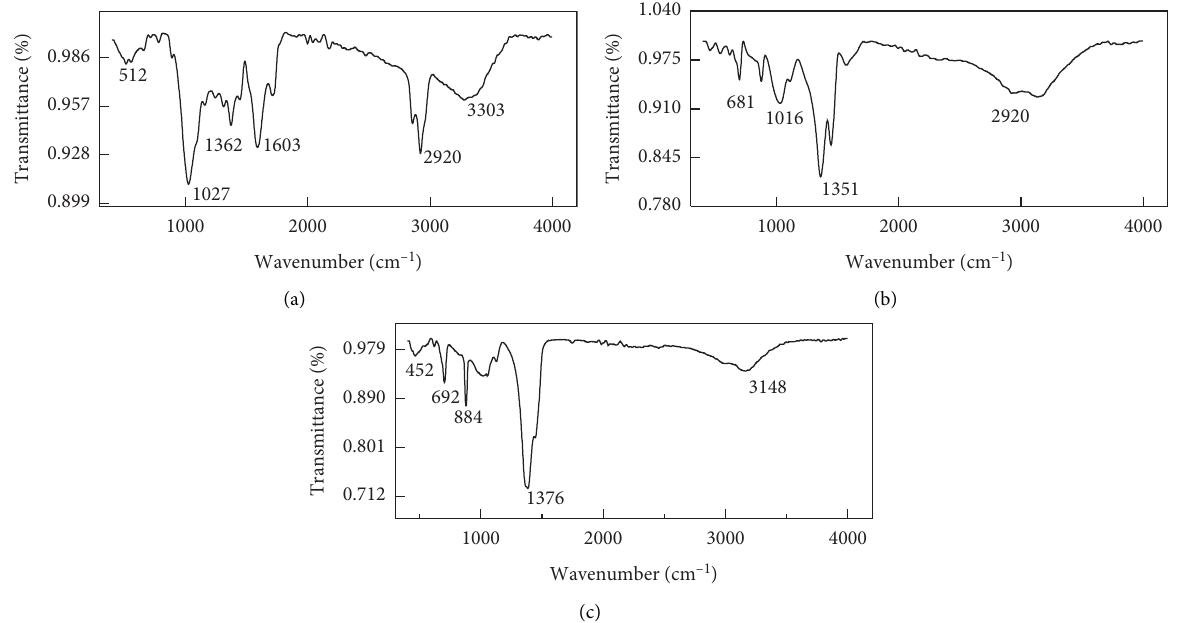
Figure 2: FT-IR peaks of banana ashes blends: (a) fresh banana ash blends, (b) burnt banana ash blends, and (c) calcined banana as